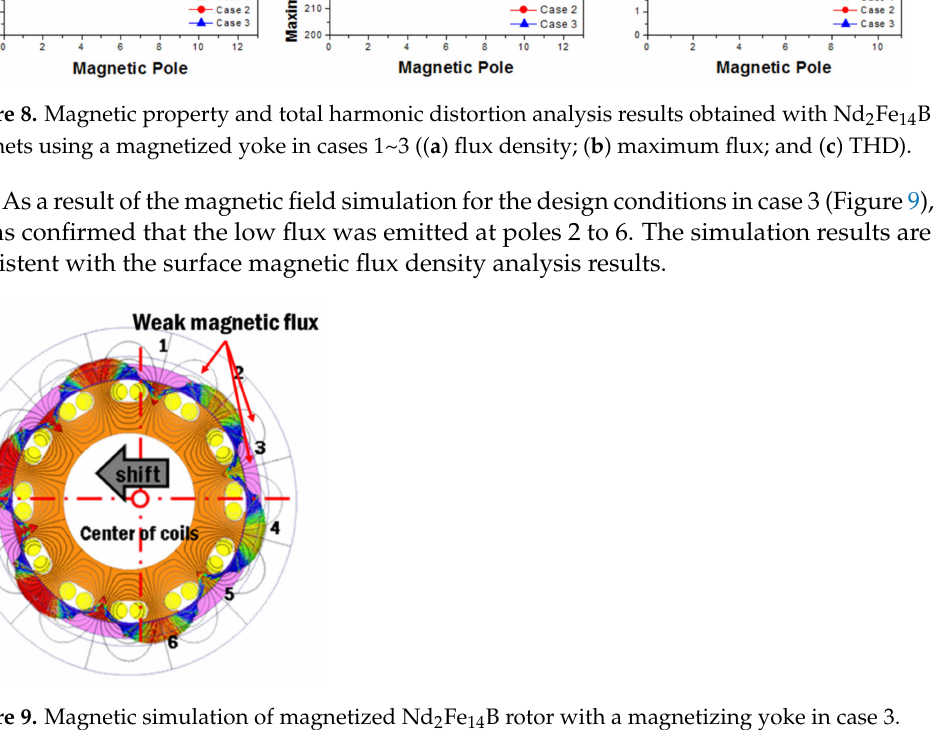
Figure 9. Magnetic simulation of magnetized Nd 2 Fe 14 B rotor with a magnetizing yoke in case